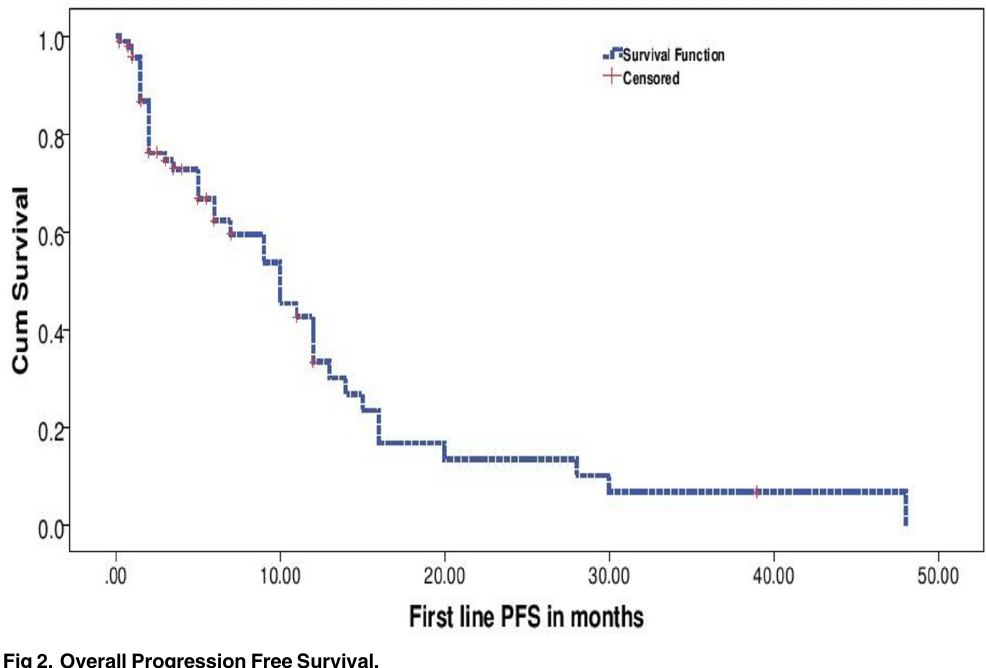
Fig 2. Overall Progression Free